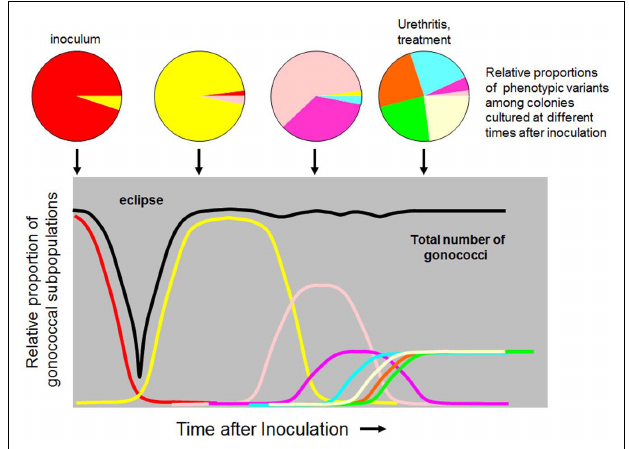
FIGURE 2 | Population dynamics during experimental gonococcal infections. The schematic representation depicts an inoculating population that is predominantly composed of one combination of variable traits, represented by red in the first pie chart and the red trace in the graph below. Following the eclipse period during which few gonococci are recovered, new variants, indicated by different colors, emerge.The population of infecting gonococci becomes increasingly complex over time. The colors represent different phenotypic variants that could arise by phase and/or antigenic variation of opacity and pilin proteins and are based on previously reported observations (Jerse et al., 1994; Seifert et al., 1994; Wright et al., 1994; Hamrick et al., 2001) but are not intended to represent specific characteristics of actual reisolates from an experimental infection.